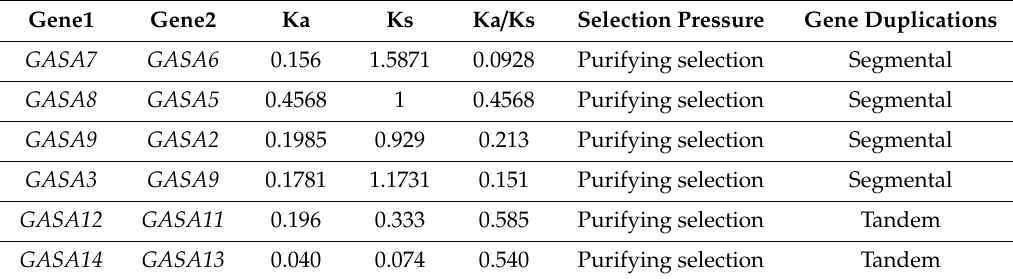
Figure 4. Chromosomal distribution and synteny analysis of grapevine GASA genes. Syntenic regions and chromosomal regions are depicted in di ff erent colors (Chr: chromosomes). Table 3. Duplications of GASA genes in